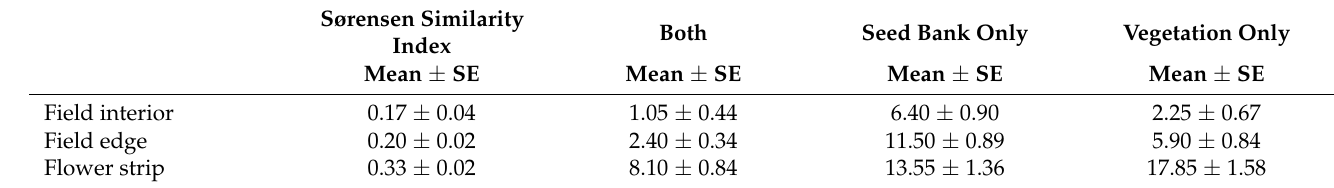
Table 3. Sørensen similarity index, and number of species present in both seed bank and vegetation or only in seed bank or vegetation in the three habitat types. Pairwise comparisons of seed bank and vegetation in field edges and flower strips. Values per transect: n = 3 × 19. Sørensen Similarity Both Seed Bank Only Vegetation